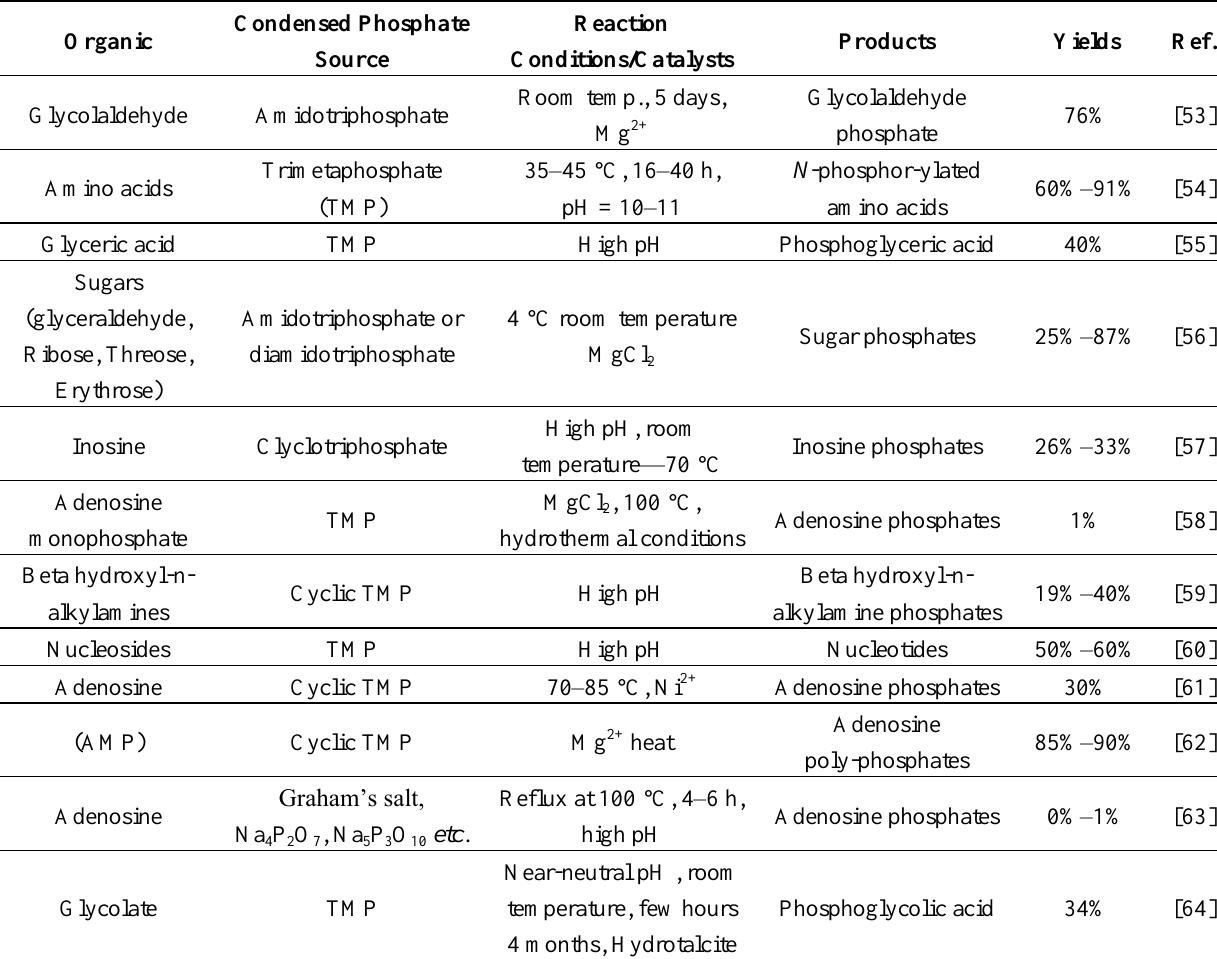
Note: Table 3 shows some phosphorylation reactions by using condensed phosphates as a source of